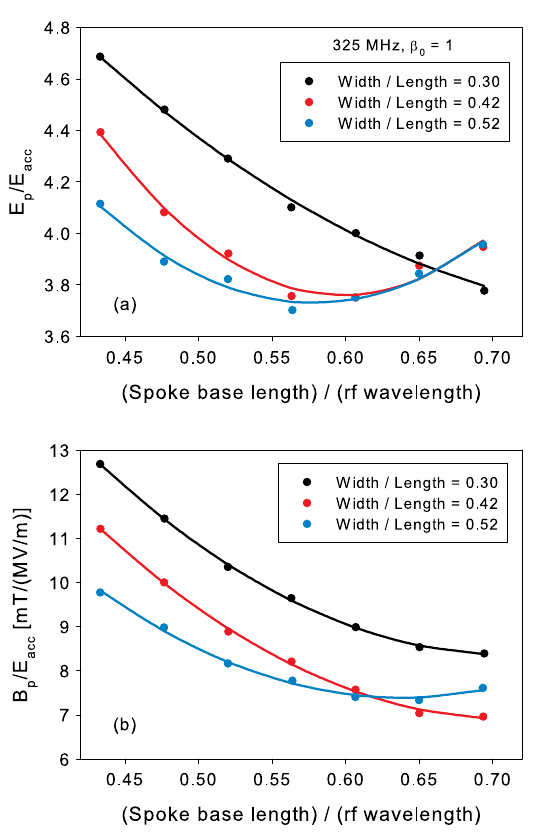
FIG. 12. Dependence of (a) E p =E acc and (b) B p =E acc on spoke base size. Three different transverse spoke base shapes are presented, identified by the ratio of base width to length. For each data point, both the base width and length are changing, but the ratio remains